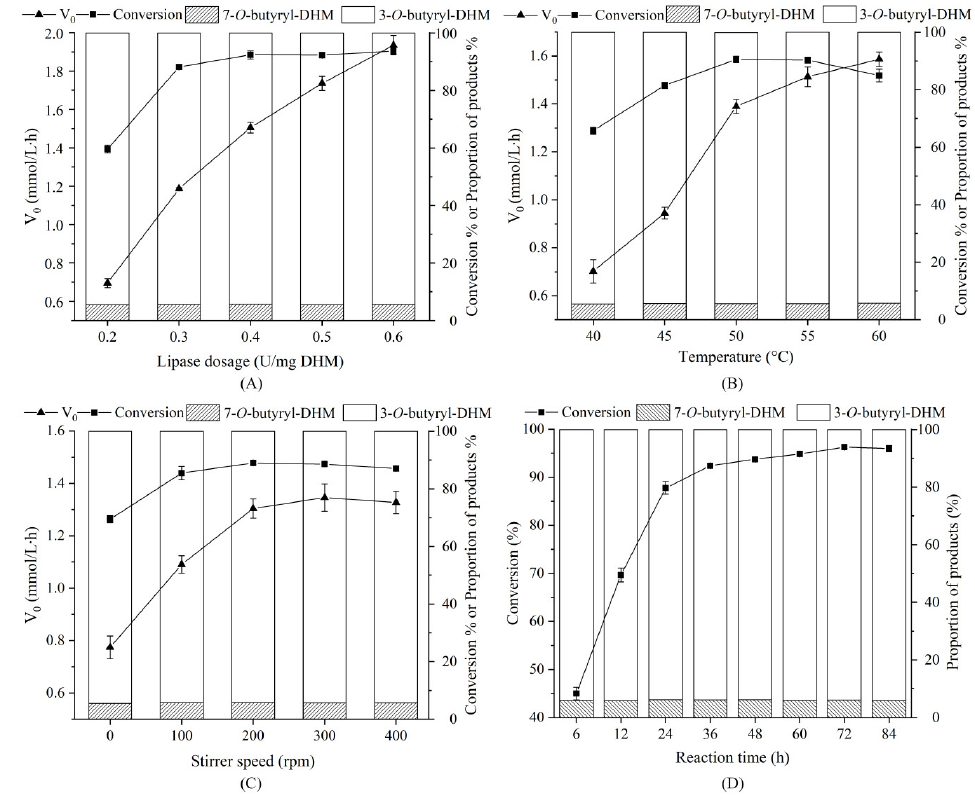
Figure 5. ( A ) Effect of lipase dosage. Reaction conditions: DHM = 0.18 mmol, vinyl butyrate =